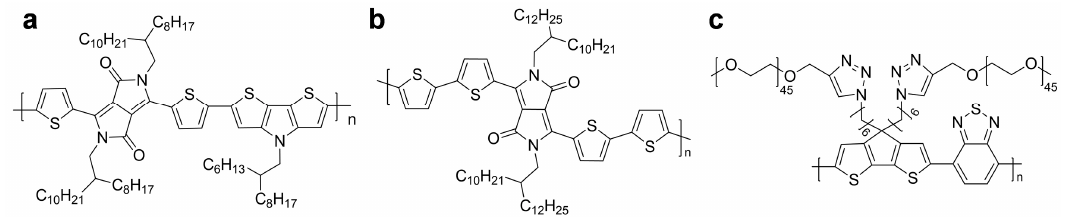
Figure8. Chemicalstructuresofsemiconductingpolymersthatsimultaneouslygenerateaphotoacoustic Figure 8. Chemical structures of semiconducting polymers that simultaneously generate a signal and heat for photothermal therapy in response to NIR-I photoacoustic signal and heat for photothermal therapy in response to NIR-I light.